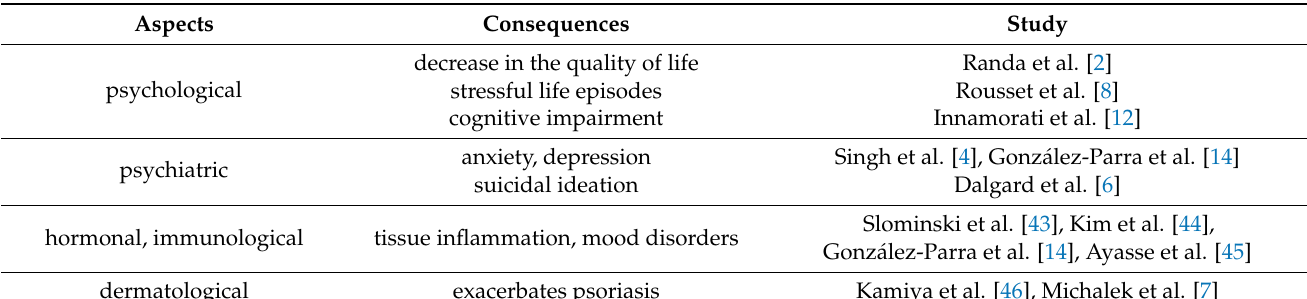
Table 1. Brain–skin axis in patients with